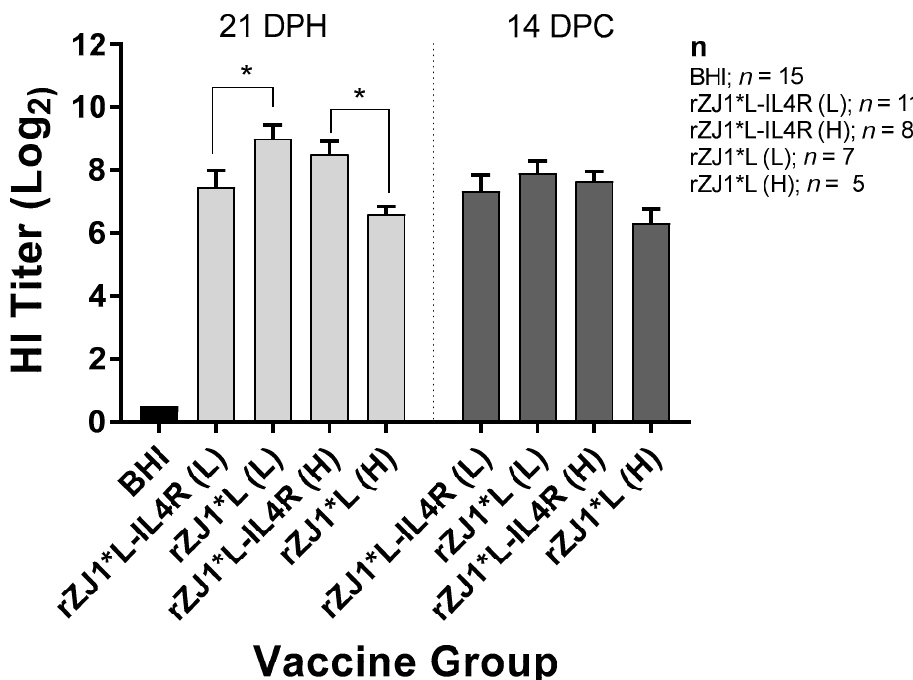
Figure 3. Effect of rZJ1*L-IL4R vaccination at 18 DOE and virulent NDV challenge at 21 DPH on HI Titers. At 18 DOE, SPF embryonated chicken eggs were vaccinated in ovo with 10 3.5 EID 50 /egg (L) or 10 4.5 EID 50 /egg (H) of rZJ1*L-IL4R, rZJ1*L, or brain heart infusion (BHI) control. At 21 DH birds were challenged with 10 5 EID 50 vZJ1. Serum was collected at 21 DPH or at 14 DPC (35 DPH). One-way ANOVA followed by a multiple comparisons Tukey’s test was done for statistical